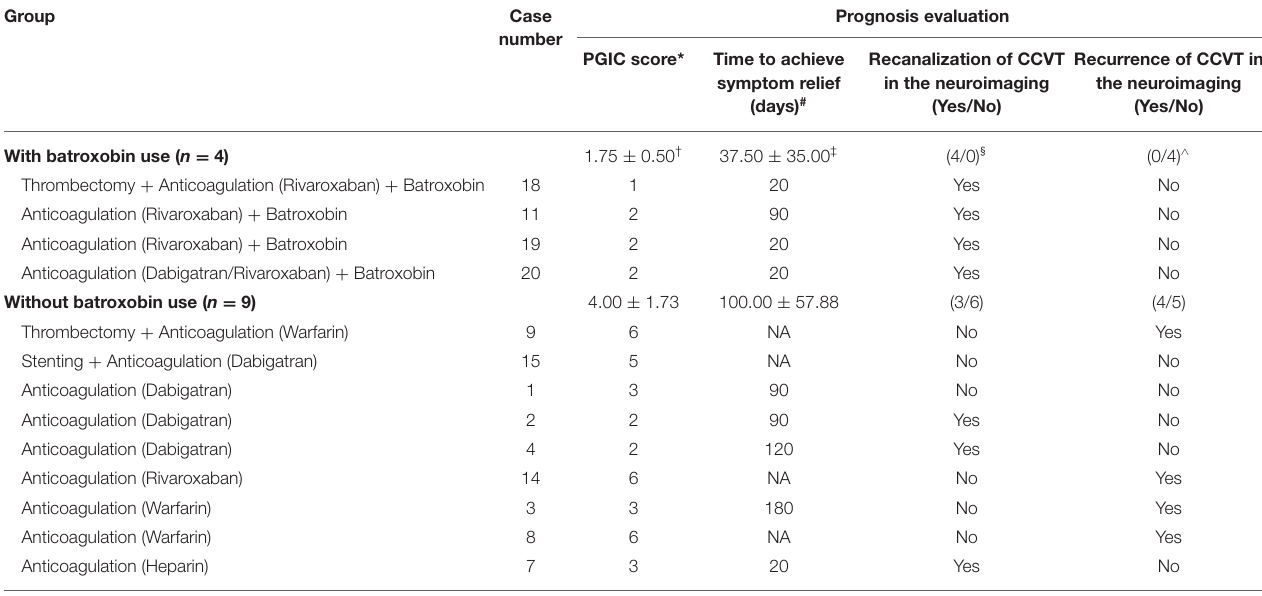
TABLE 3 | Subgroup analysis of prognosis in patients with/without batroxobin use. Group Case